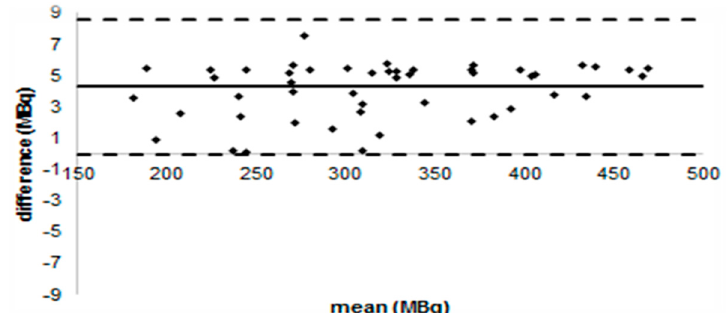
Figure 3. Residual activity remaining in syringe after injection versus injected activity in a cohort of 50 patients from Santa Croce e Carle Hospital. Injection is carried out with a three-way valve system and the syringe is flushed with physiological saline after the injection. Full line represents average residual activity while dashed lines are the 95% confidence interval (±2 standard deviation).